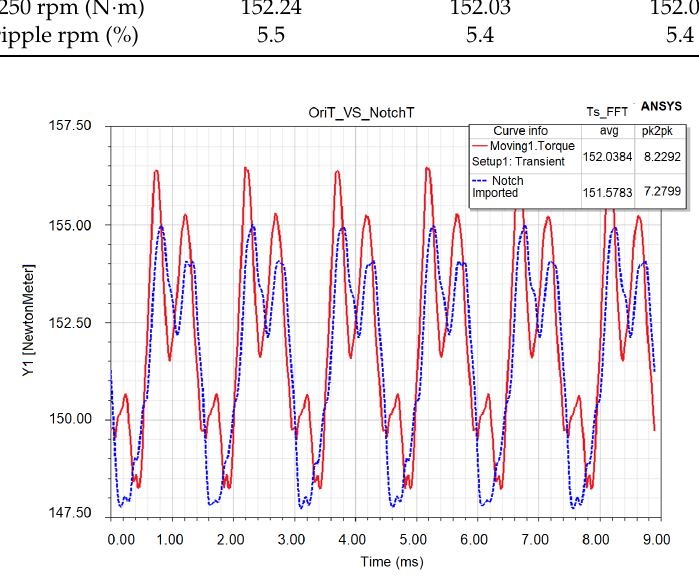
Figure 9. The rated torque waveform of initial and optimized design. Table 9. Optimization design results of rotor rivet hole position.